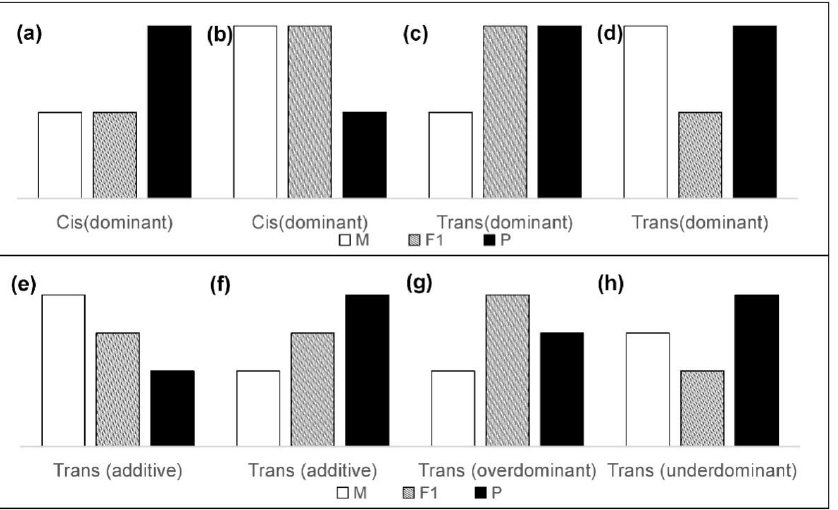
Figure 2. Hypothetical classification of regulatory divergence. Classification according to the ex- pression level in the maternal parent (mother of CL: Cor/mother of LC: WL), paternal parent (father of CL: WL/father of LC: Cor)), and F1 hybrids (CL/LC). Subdivide the ‘Cis’ ( a , b ) and ‘Trans’ ( c – h ) main categories are listed. “M”, “F1”, and “P” are the abbreviations for “mother”, “F1 hybrid”, and “female of father breeds” respectively.